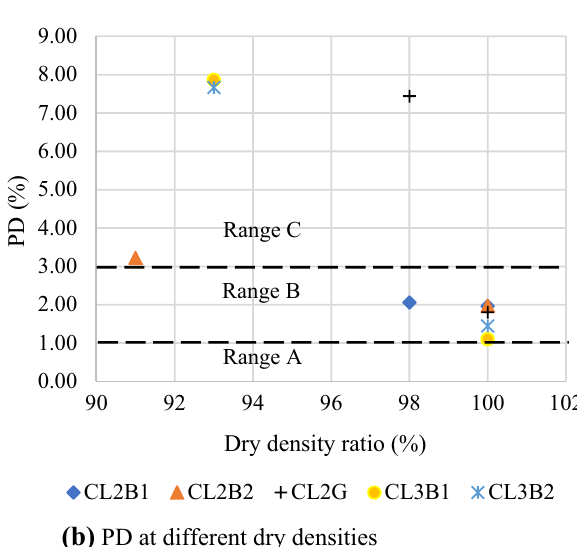
(b) PD at different dry densities Fig. 12 New shakedown limits